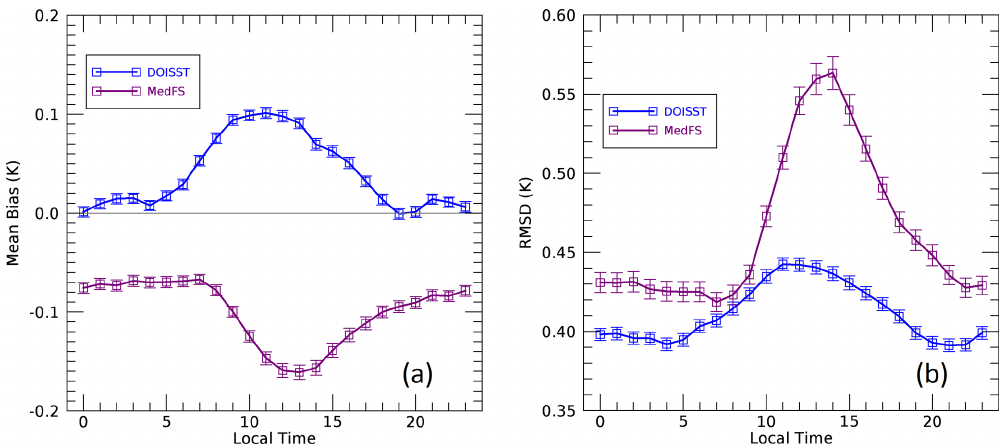
Figure 3. (a) Mean bias (K) and (b) RMSD (K) relative to MED DOISST (blue line) and MedFS (purple line), based on the differences against drifters’ data. Mean bias and RMSD are given as an hourly mean over the period 2019–2020. Table 4. Summary statistics of MED DOISST and MedFS products based on the differences against drifters’ data over the matchup points. Mean bias (K), RMSD (K), and number of matchups are given as an hourly mean over the period 2019–2020. Each statistical parameter is associated with a 95% confidence interval computed through a bootstrap procedure (Efron and Tibshirani,